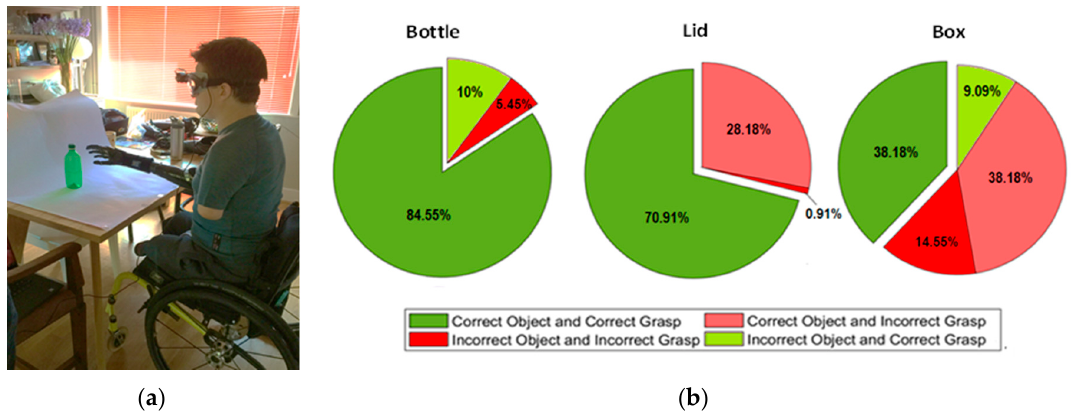
Figure 5. ( a ) The amputee is carrying out the classification performance assessment on a bottle using a power grasp. ( b ) Pie charts displaying the average classification outcomes for each object across both able-bodied and amputee participants. In total, there were seven classes of grasp pattern. The outcome